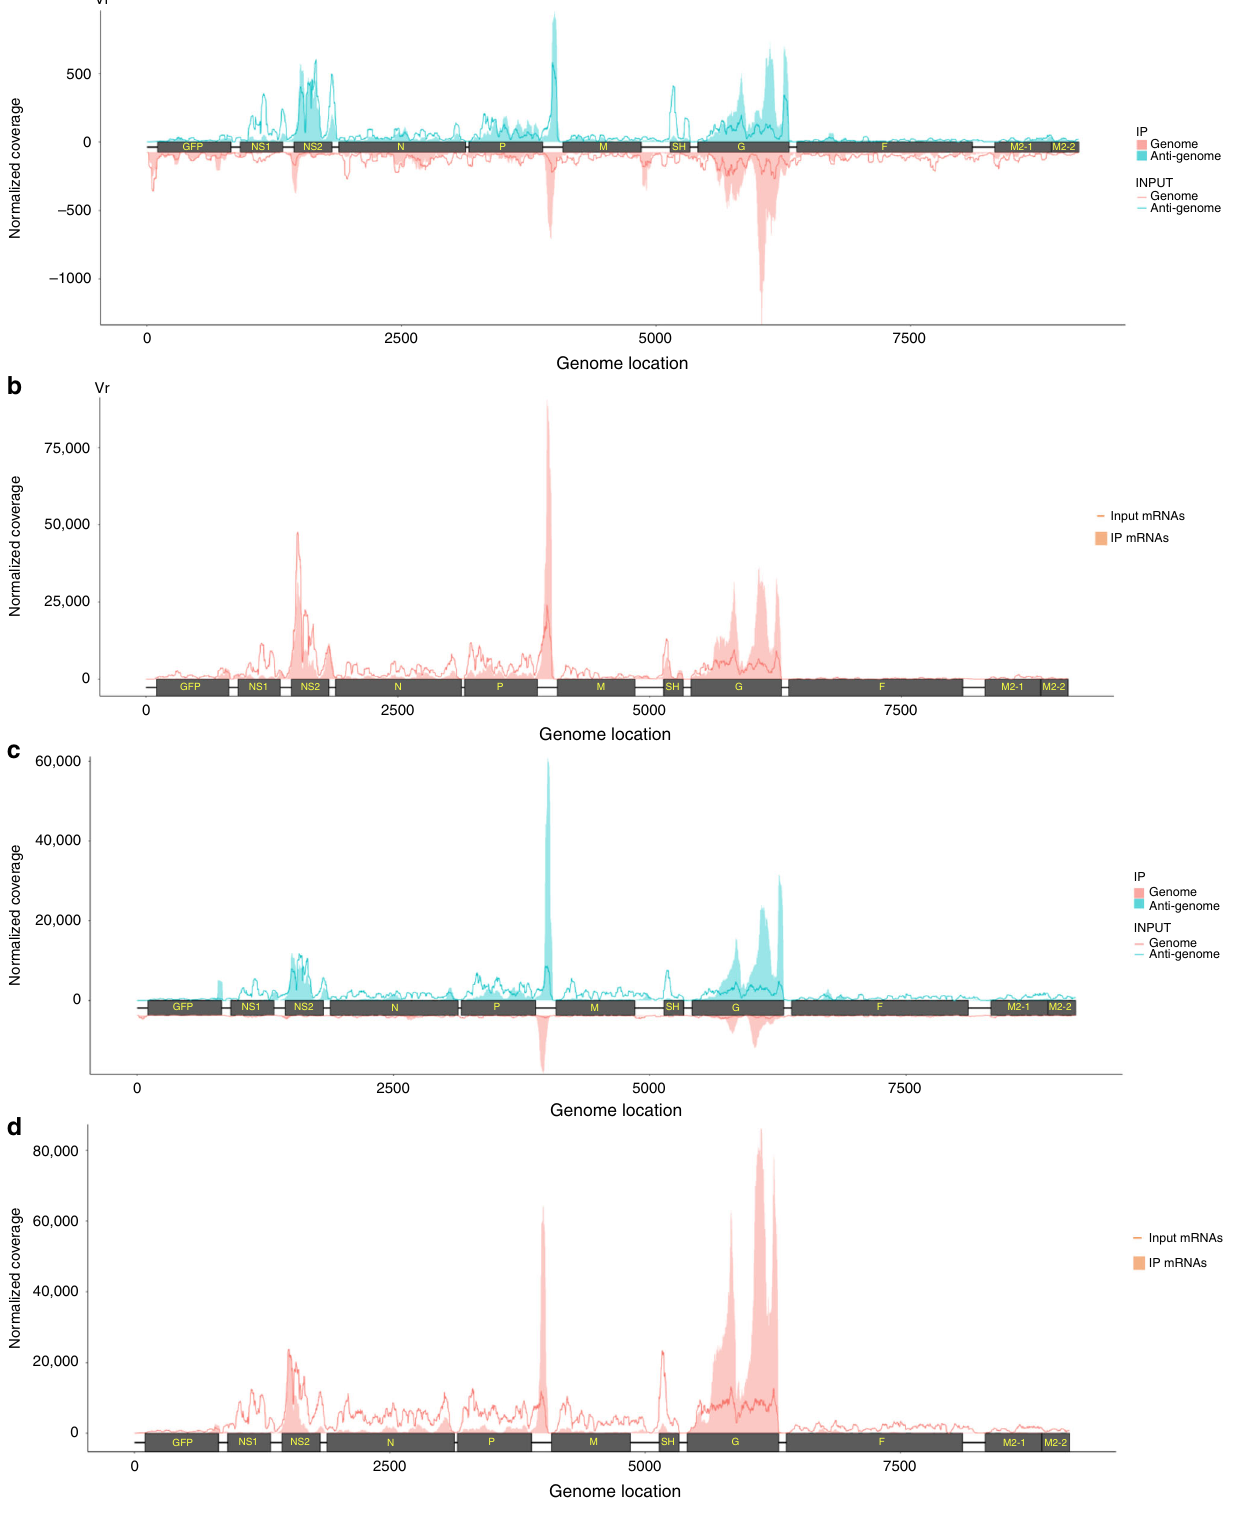
Supplementary Fig. 2B and Supplementary Table 2) which largely overlapped with those of the antigenome (Fig. 1a, Supplementary Fig. 2A and Supplementary Table 1). Interestingly, the G gene transcript has the strongest m 6 A enrichment with a 846 bp peak size. In addition, no m 6 A peak was detected in GFP mRNA in virus-infected HeLa